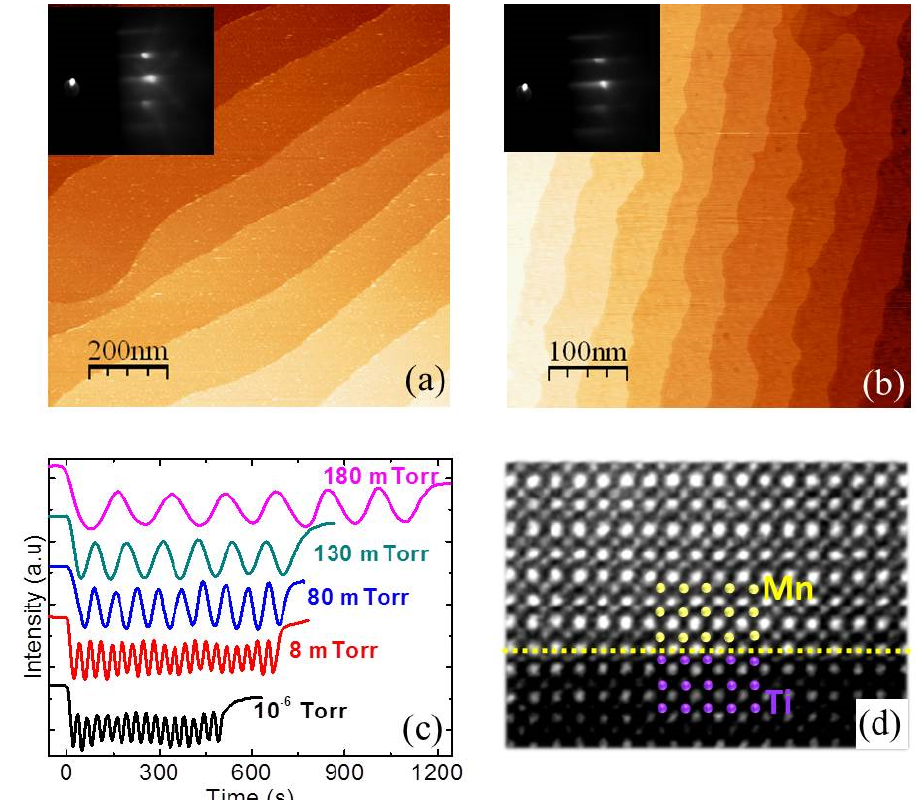
Figure 3. Surface morphology of ( a ) the SrTiO 3 substrate and ( b ) 10 u.c. La 2/3 Sr 1/3 MnO 3 (LSMO) thin film imaged by scanning tunneling microscopy. Inset of (a) and (b) show the corresponding Reflection High-Energy Electron Diffraction (RHEED) pattern. ( c ) RHEED intensity monitored during growth at different oxygen partial pressures. ( d ) Cross-section of a scanning transmission electron microscopy (STEM) image of the LSMO/STO (TiO 2 -terminated SrTiO 3 ). Figure is adapted from Ref. [39].